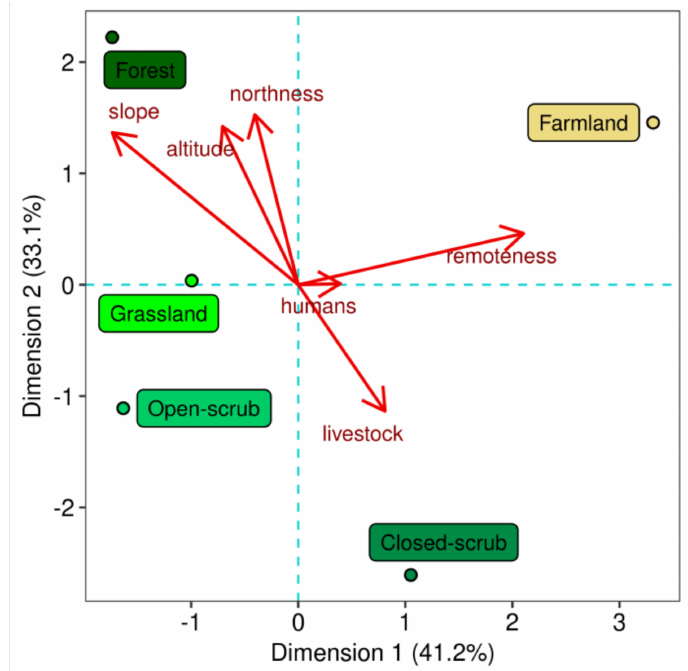
Figure 8. The change in LUC type conditions when moving from the most (SSP-SUST) to the least (SSP-FUEL) optimistic climatic scenario. In this factor map from the MFA, a more similar direction between a LUC type and an environmental predictor means that the LUC type was predicted at map cells with higher values of the environmental factor under the least optimistic climatic scenario. The MFA regarded only the map cells which differed in the prediction of LUC between the most and least optimistic climatic scenarios. We employed the six environmental factors which were fixed in time and the most important in the spatial allocation of demand. The MFA took into account all four scenarios of demand in the 2015–2055 LUC transitions, grouping the same environmental factor across the demand scenarios (i.e., six sets of four variables). The factor map’s axes provide the percent of variance retained by the first two dimensions of the